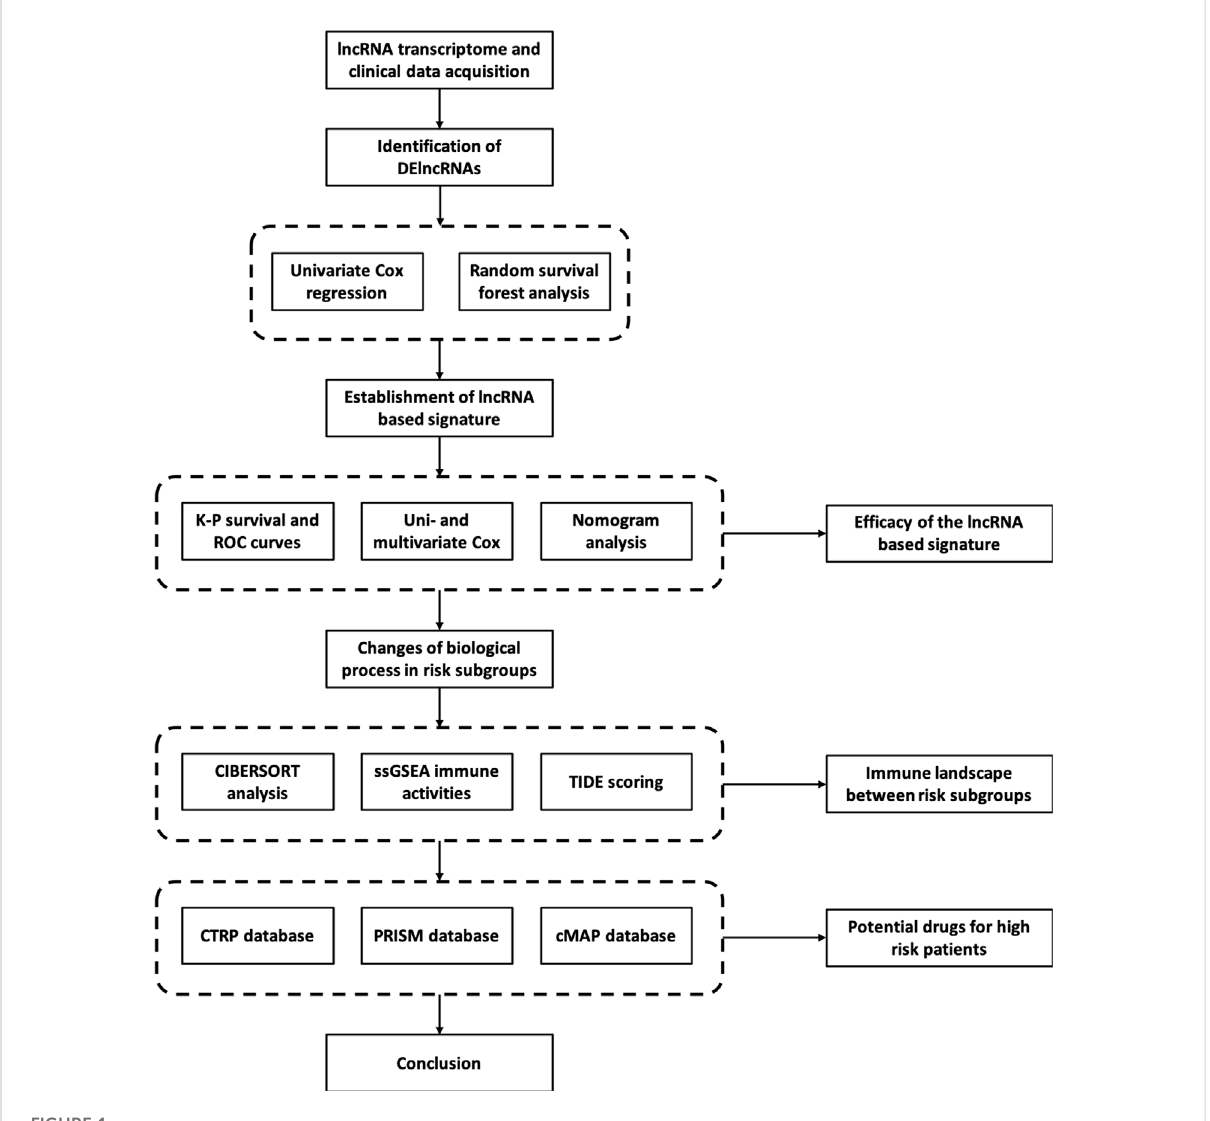
FIGURE 1 The work fl ow of the